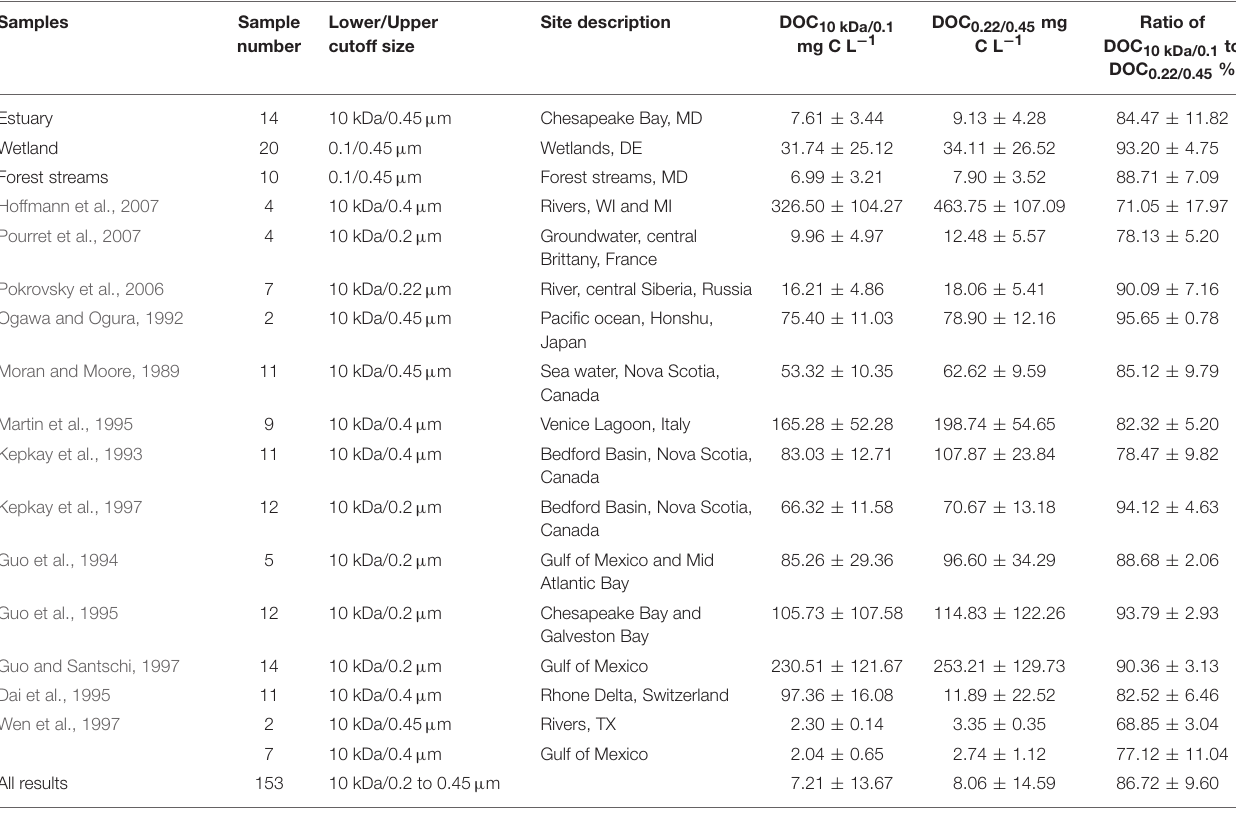
TABLE 4 | The ratios of DOC 10kDa / 0.1 to DOC 0.22 / 0.45 from this study and literature. Samples